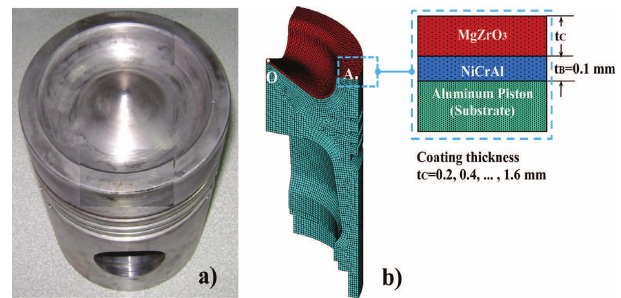
Fig. 6. Piston in the research: a) piston, b) coating mesh, coating composi- tion and its parameters [3]